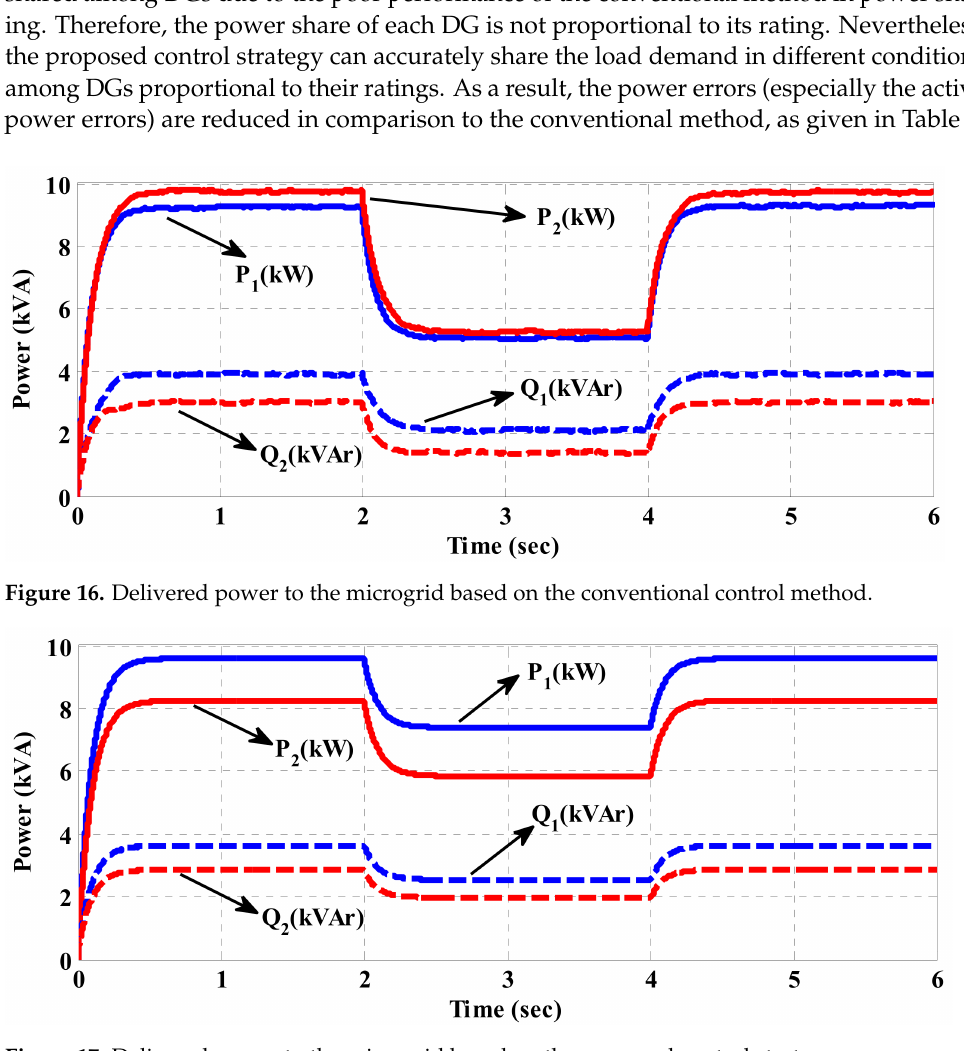
Figure 17. Delivered power to the microgrid based on the proposed control